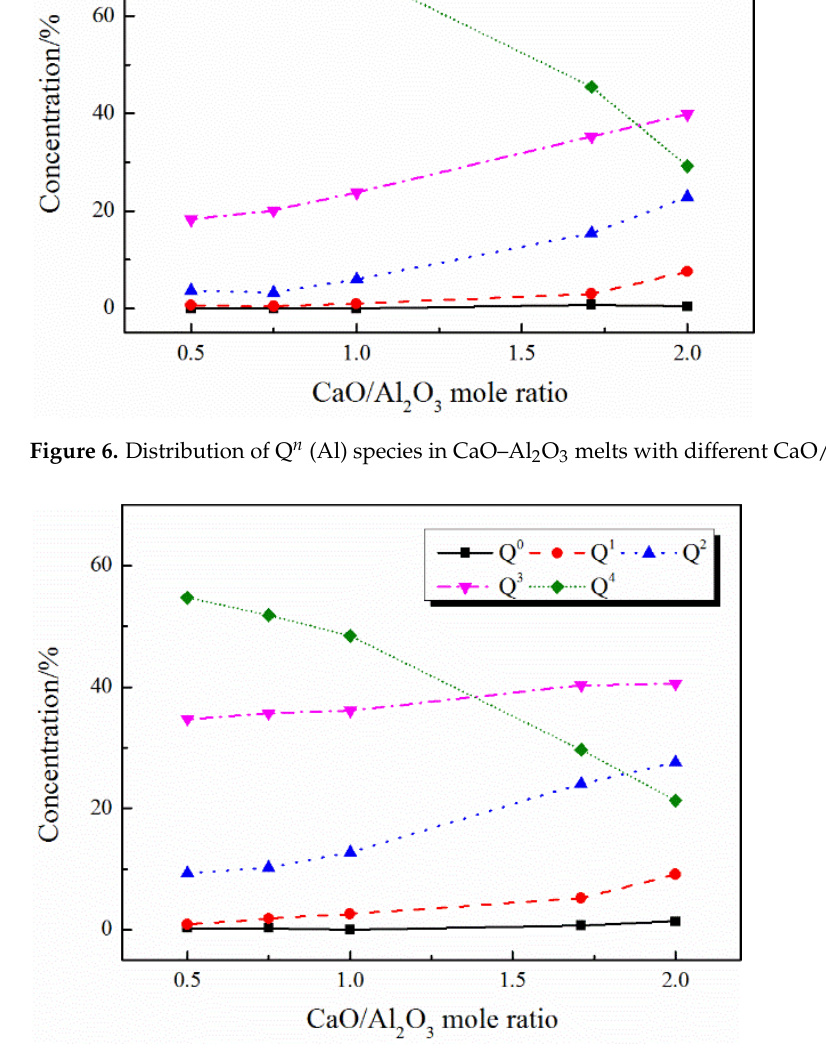
Figure 7. Distribution of Q n (Al) species in CaO–Al 2 O 3 –B 2 O 3 melts with different CaO/Al 2 O 3 mole ratios.